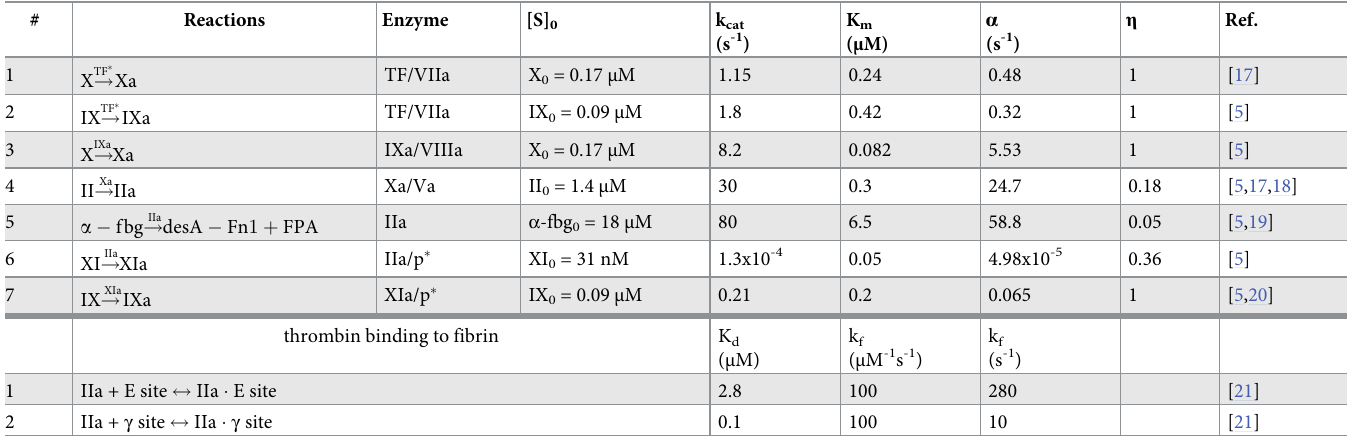
Table 1. Reactions and kinetic parameters used in the ODEs model.